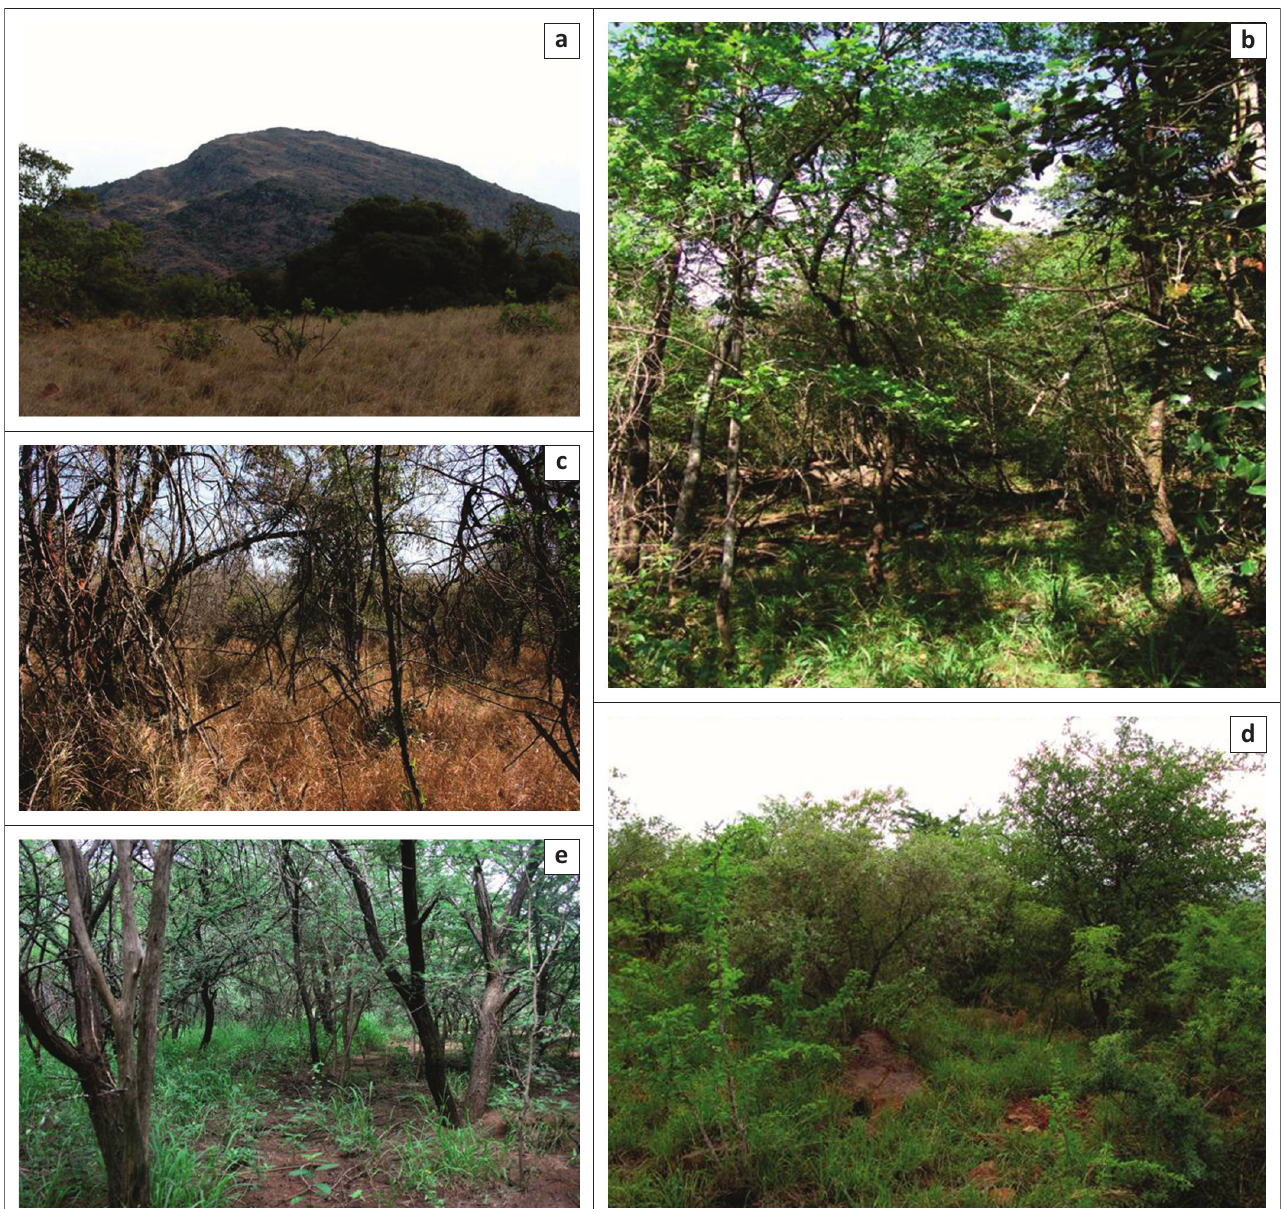
FIGURE 3: (a) Low shrubland patches (14S) with shallow rocky soils on quartzite, dominated by Coleochloa species. (b) Tall forest (12S) dominated by woody species of Croton sylvaticus and Ekebergia capensis . (c) Short forest (12S2). Low elevation sites: (d) Thicket site (10S) on clay soils dominated by woody species such as Acacia caffra and Olea europaea . (e) Shrubland (09S) on clay soils dominated by woody species such as Dichrostachys cinerea